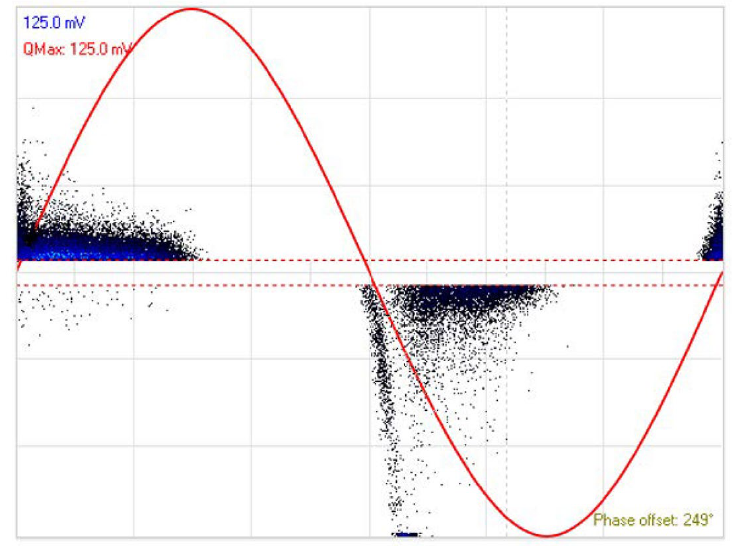
Figure 8. PD patterns detected by the HFCT sensor, under an AC-applied voltage of 8.2 kV (red).